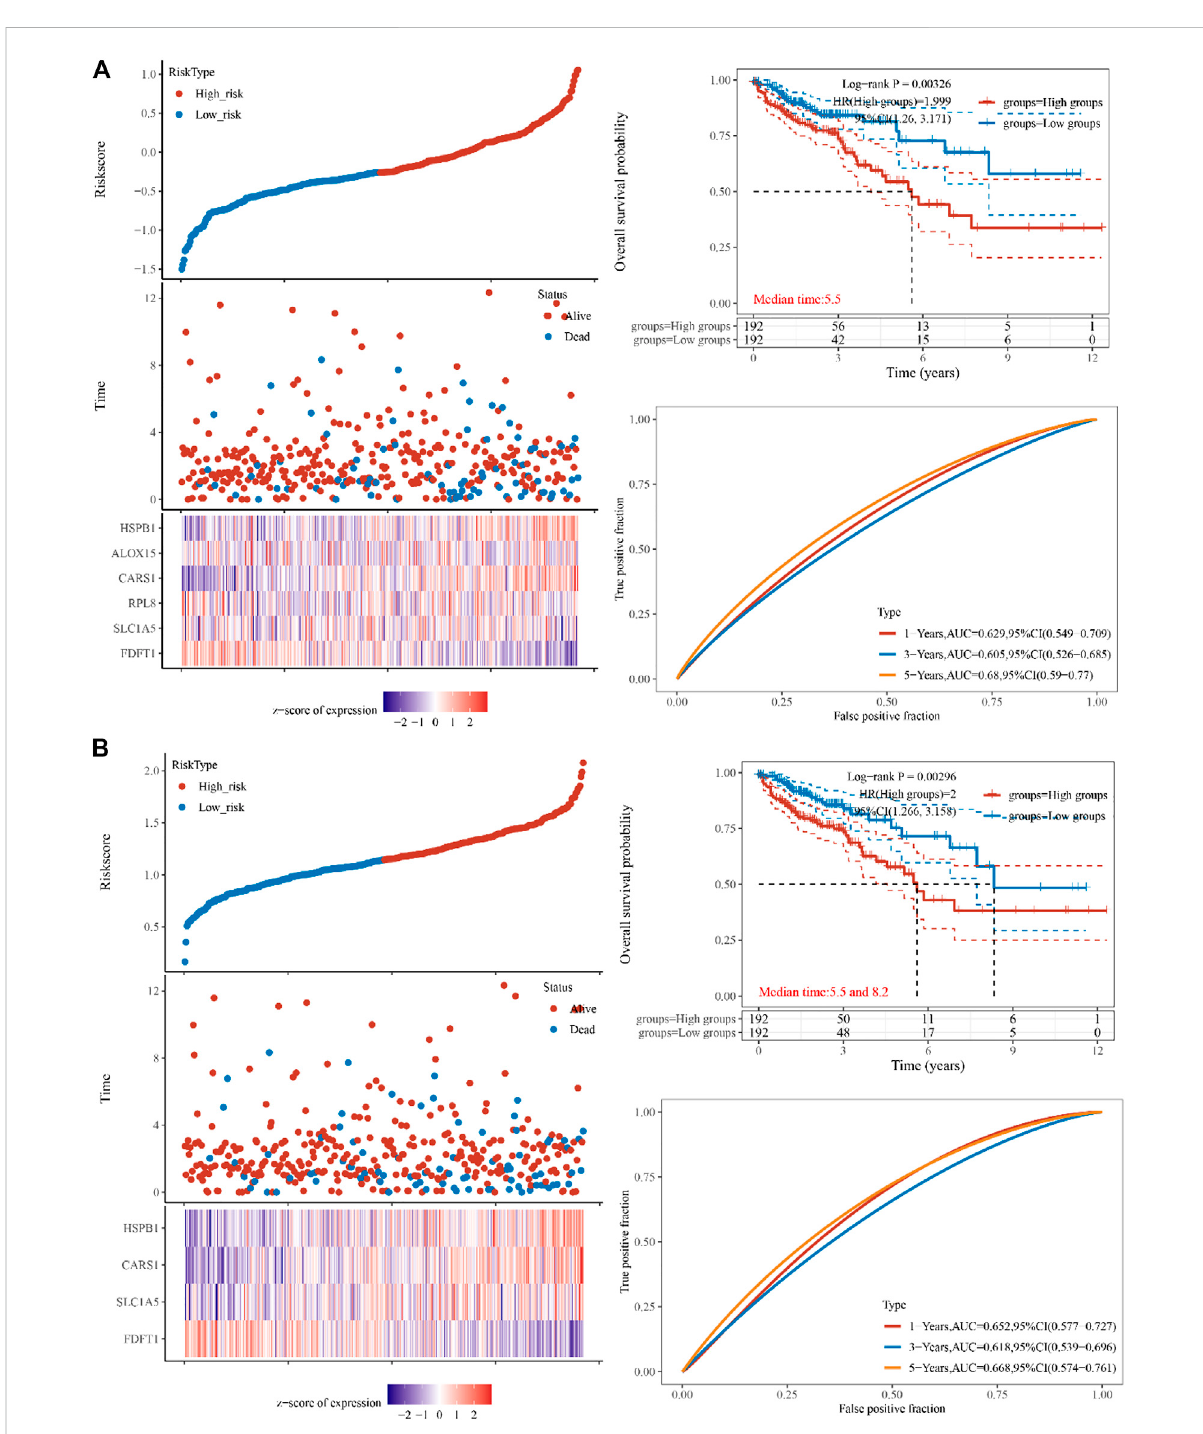
FIGURE 2 ConstructingtheTCGAcohort ’ sgenes. (A) Themulti-factorcoxregressionanalysisshowedsixprognosisrelatedgenesincoloncancer (B) The forest analysis showed four prognosis related genes in colon cancer using 10x cross-validation ( p < 0.05) The top scatters represent TCGA cohort ’ s riskscoredistribution fromlowtohigh.Kaplan-Meiersurvivalanalysis oftheriskmodelfrom dataset,comparisonamongdifferentgroupswasmade by log-rank test. HR (High exp) represents the hazard ratio of the low-expression sample relatives to the high-expression sample. HR > 1 indicates the genes are a risk factor, and HR < 1 indicates the genes are a protective factor. HR (95%Cl). Heatmap is the gene expression from the signature. Prognostic performance was evaluated using the AUC of the time-dependent ROC curve analysis for OS in the TCGA